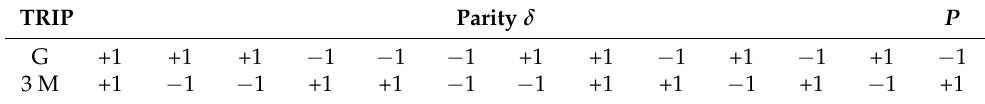
Table 3. Parities δ and their product P of spin-degenerate states at TRIP for SbXH n and BiXH n .